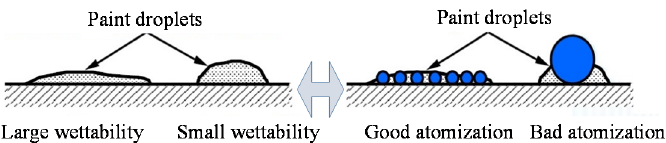
Figure 7. Effects of wettability and paint particle size on final coating smoothness.